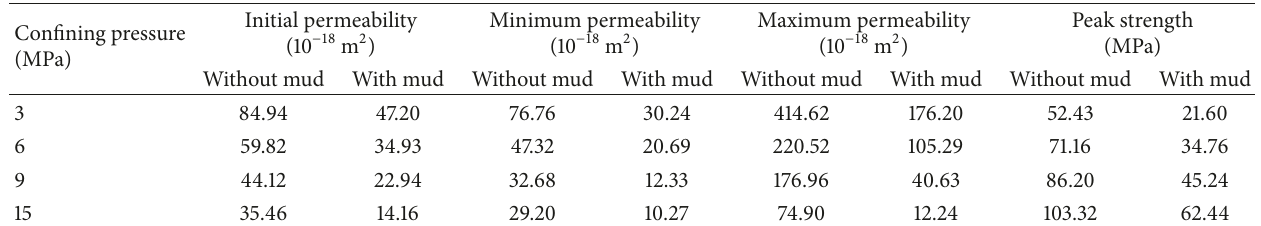
Table 3: Permeability property and strength considering water pressure 2 MPa and different confining pressure. Confining